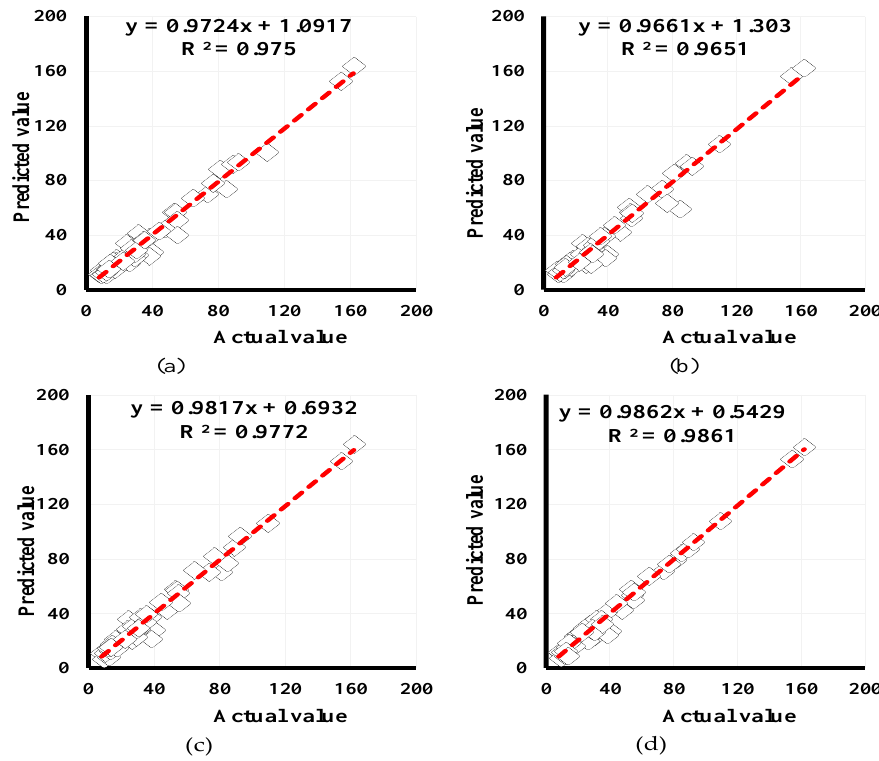
Figure 5. Correlation charts for the training results of ( a ) HHO – ANFIS, ( b ) SSO – ANFIS, ( c ) TLBO – ANFIS, and ( d ) WCA – ANFIS.